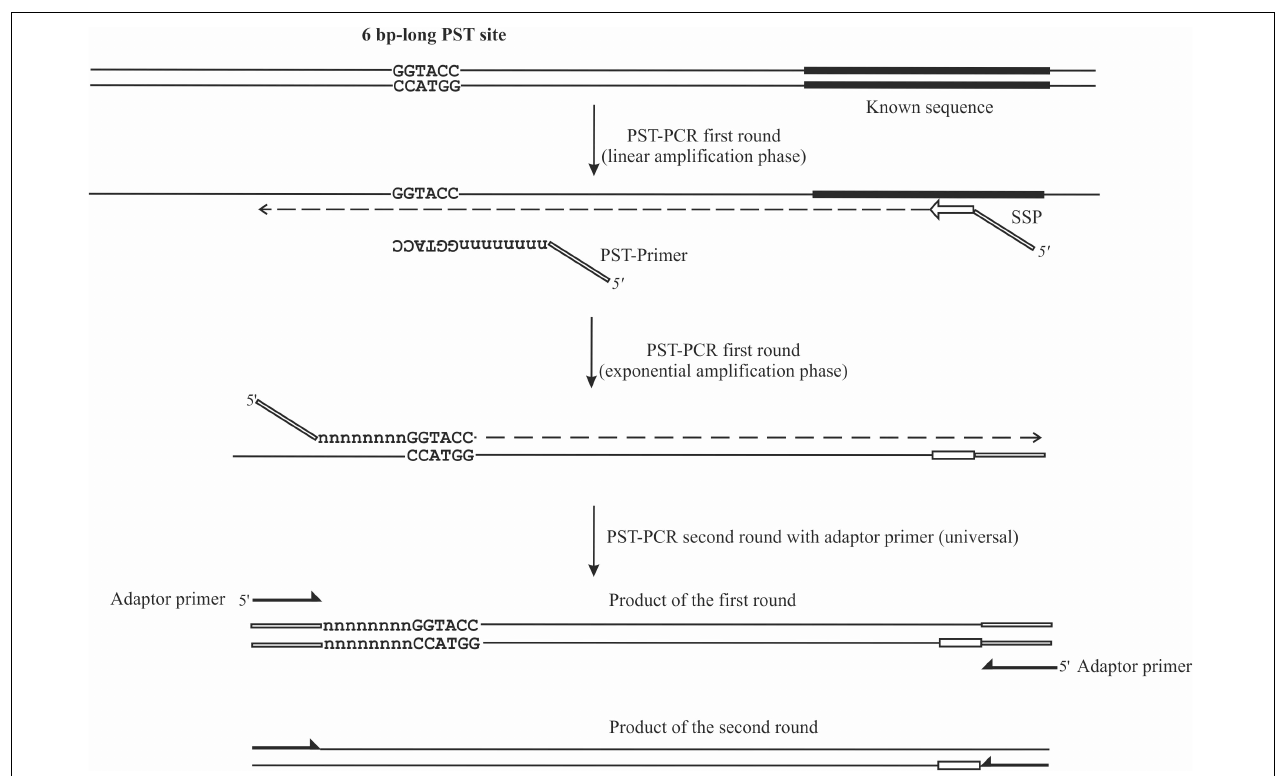
FIGURE 1 | Schematic depiction of PST-PCR v.2. The figure shows two consecutive PCR rounds. The first round was performed with a 5 (cid:48) -tailed sequence-specific primer (SSP) and one PST primer. The SSP primer anneals to a target with a known sequence. The PST primer anchors to a palindromic sequence in a region with an unknown sequence. The second round was performed with a single-tail primer. The regions with known sequences are depicted with thick lines. Other regions of the template with unknown sequences are shown as thin lines.